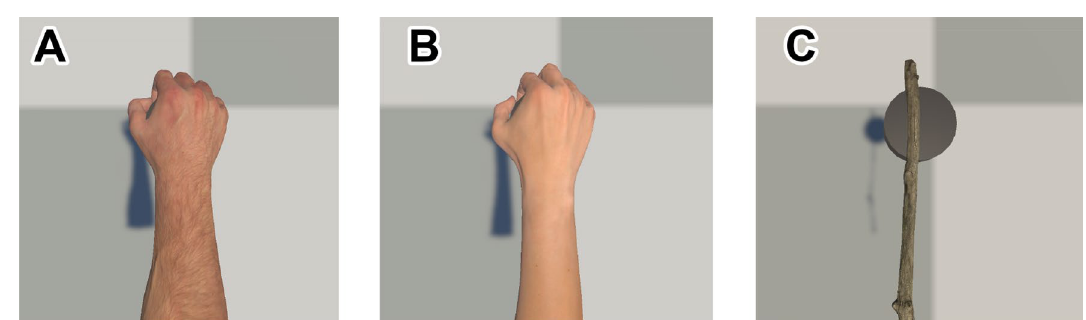
Figure 4. Two types of avatars were used in the experiment. For realistic hand avatars, gender-matching avatars ( A : male, B : female) were implemented. For branch avatars ( C ), the length was identical to that of the realistic hand counterpart. Each avatar held a black object that imitated a haptic